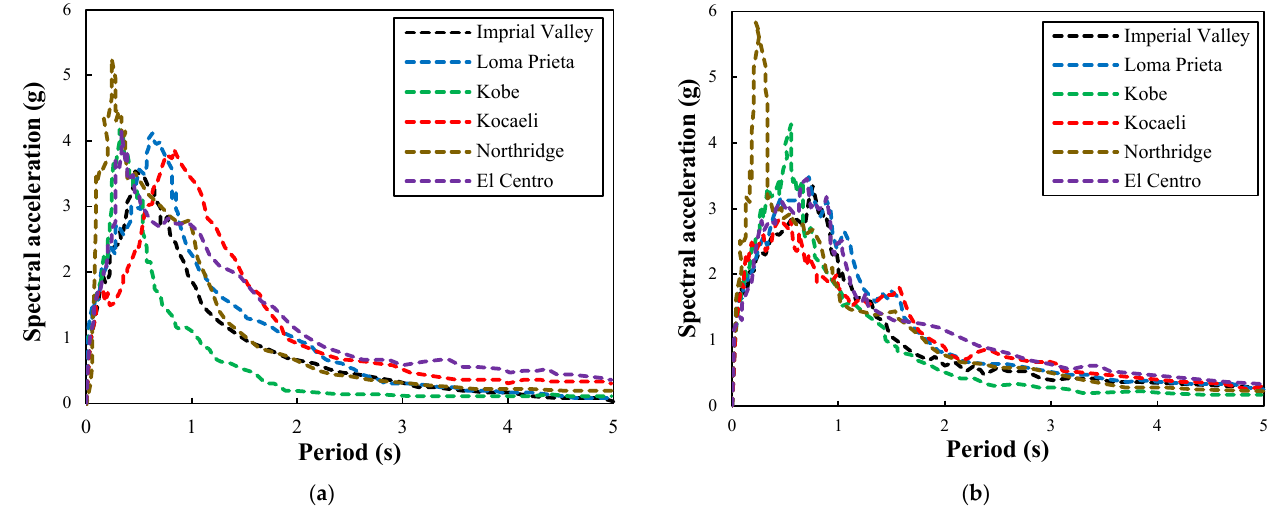
Figure 9. Spectral acceleration of the ground motion records used in this study: ( a ) far ‐ fault and ( b ) near ‐ fault ground motions.